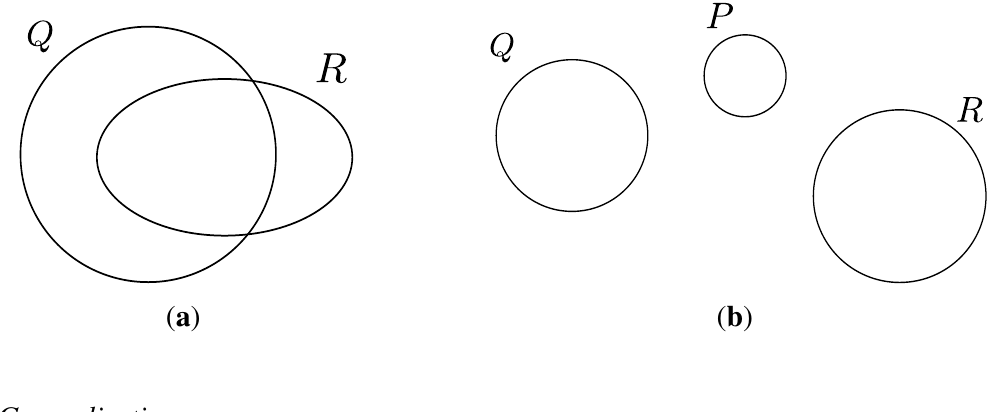
Figure 2. In ( a ) the object R is nearly completely contained inside the object Q ; In ( b ) the object P is between the objects Q and R